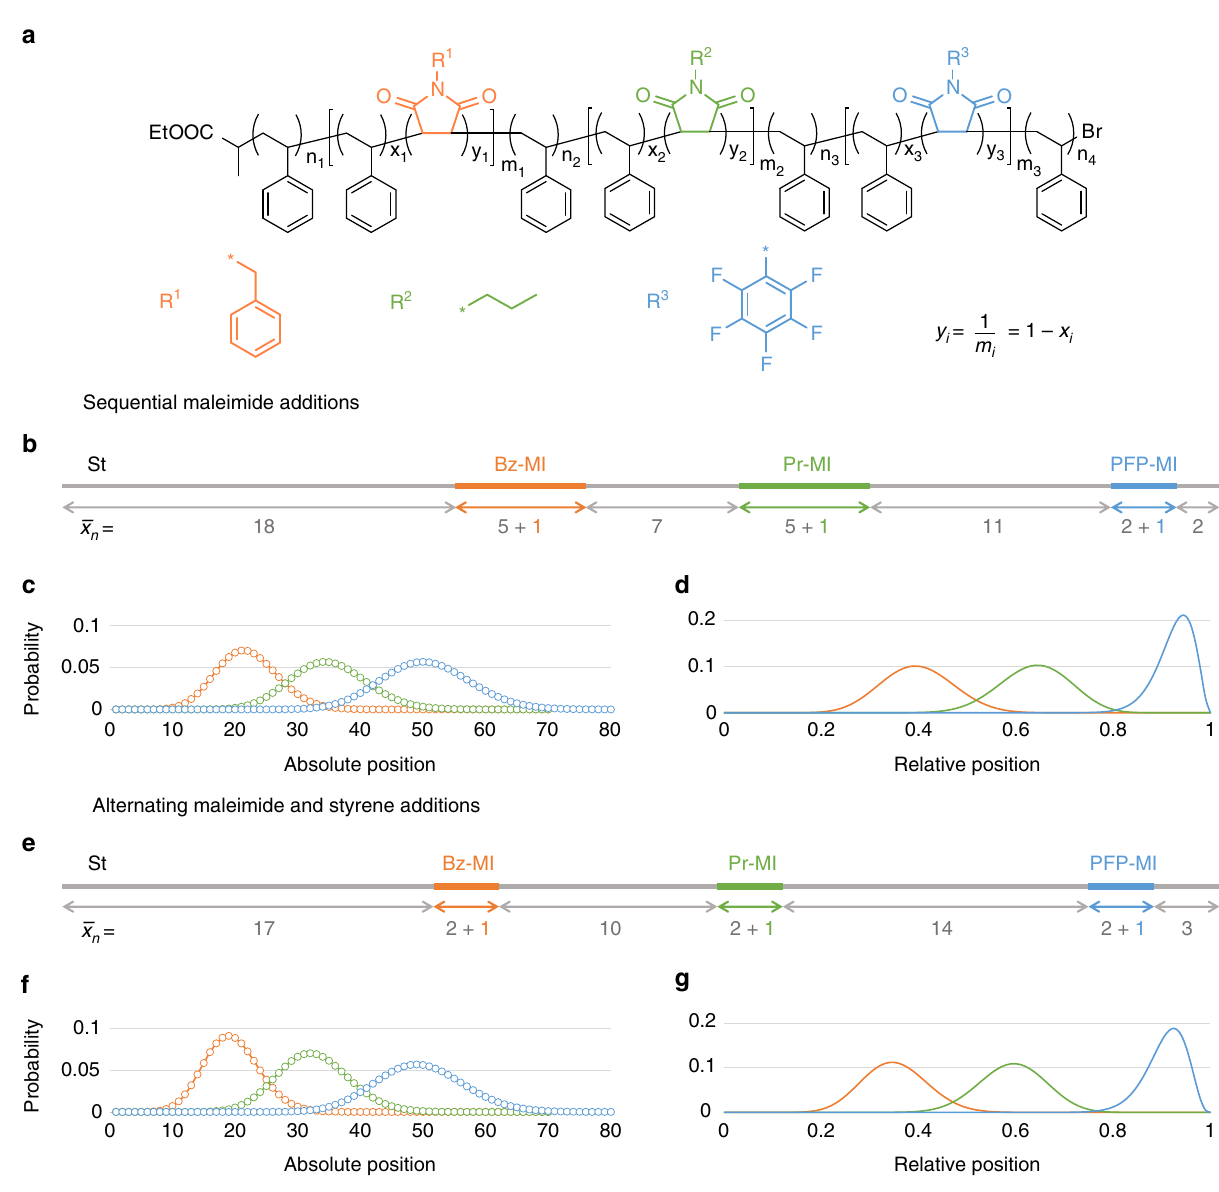
Figure 3 | Comparison of multisite copolymers. ( a ) containing benzyl maleimide (Bz-MI), propyl maleimide (Pr-MI) and pentafluorophenyl maleimide (PFP-MI) insertions, prepared using maleimide additions only ( b – d ) or by alternating additions of maleimide and styrene ( e – g ) to an SET-LRP polymerization of styrene 21 . The expected structures of each copolymer ( a , b , e ) consist of short regions containing a single maleimide unit, dispersed along a polystyrene chain. The distribution of each type of maleimide is shown in terms of absolute position ( c , f ) and position relative to the total chain length ( d , g